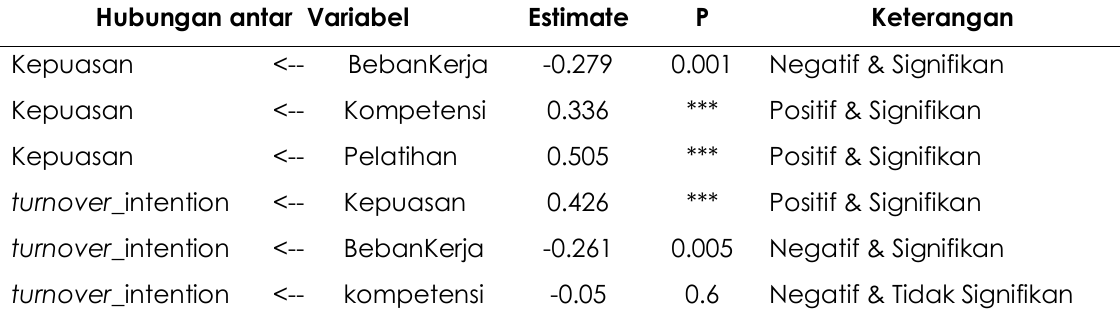
Tabel 6. Loading Factor dari Variabel